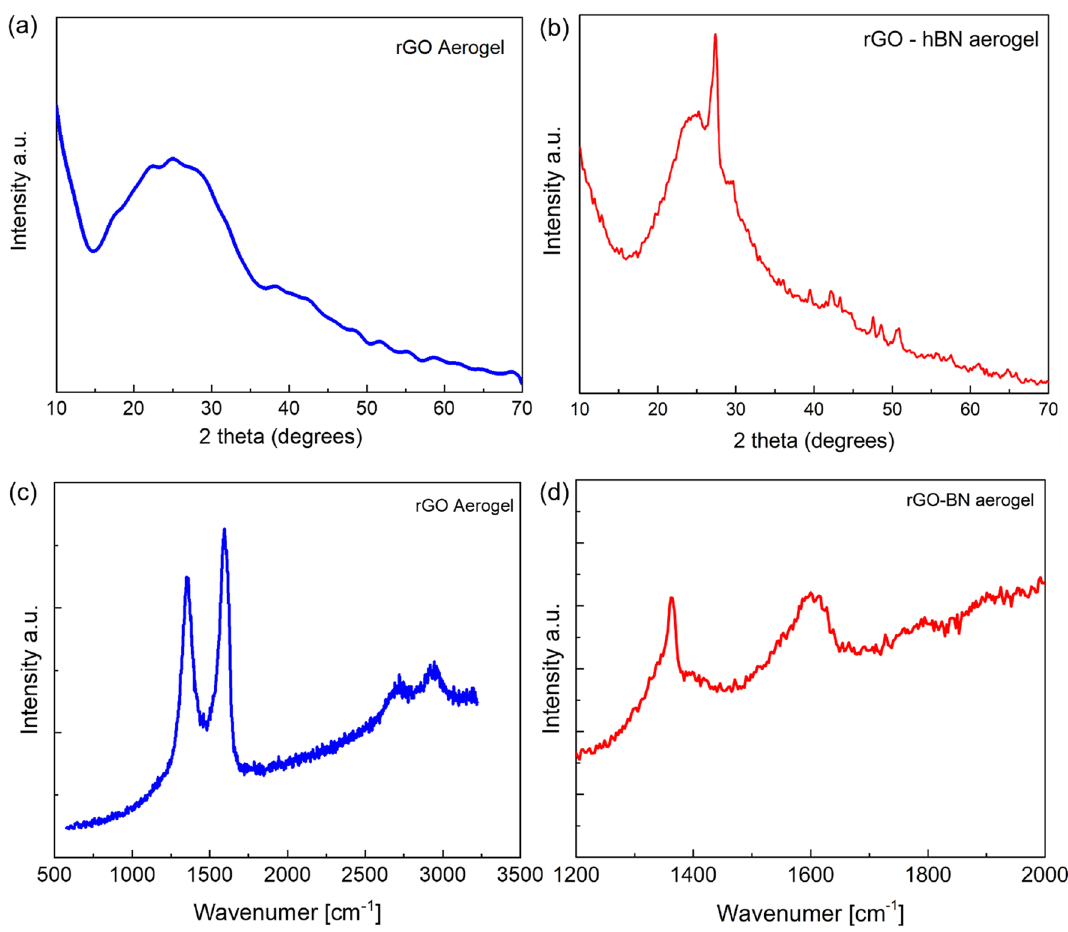
Figure 3. ( a , c ) XRD and Raman spectra of the rGO and the corresponding spectra ( b , d ) for the rGO-hBN aerogels samples. The as-made rGO aerogel exhibits a weak broad peak, characteristic of an amorphous material, at 2θ = 26°, which corresponds to the (002) plane of graphite structure, as reported elsewhere 34 . The hybrid rGO–hBN aerogel shows mainly the before-mentioned rGO peak at 2θ = 26° and also a clear peak at 27.3° which is attributed to the (002) diffraction peak of hBN 12 . The characteristic G and D peaks are clearly seen in the Raman spectra for the rGO and also the presence of hBN is confirmed by the peak of the E 2g phonon at ~ 1366 cm −1